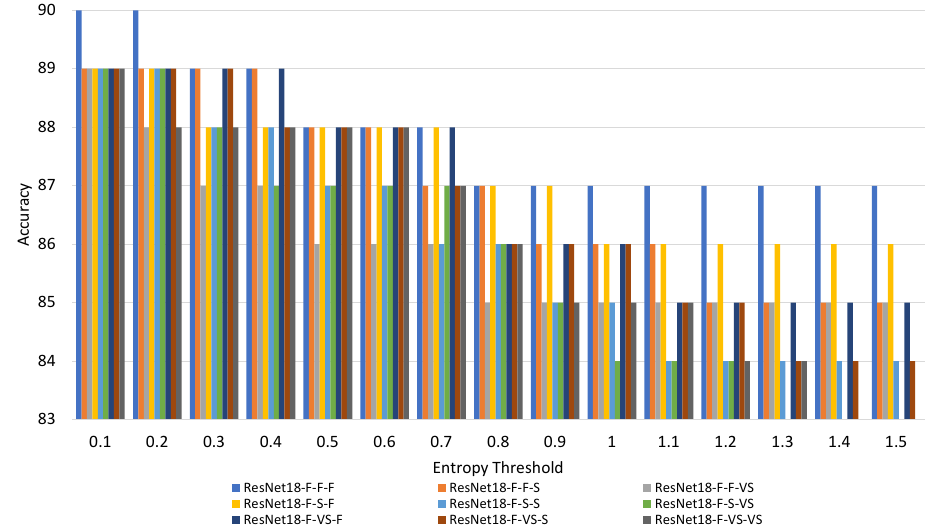
Figure 3. Accuracy of the dual model for different combinations of a small model with ResNet50. The small models in the graphic are all variants of ResNet18 described above restricted to the repetition pattern of the original